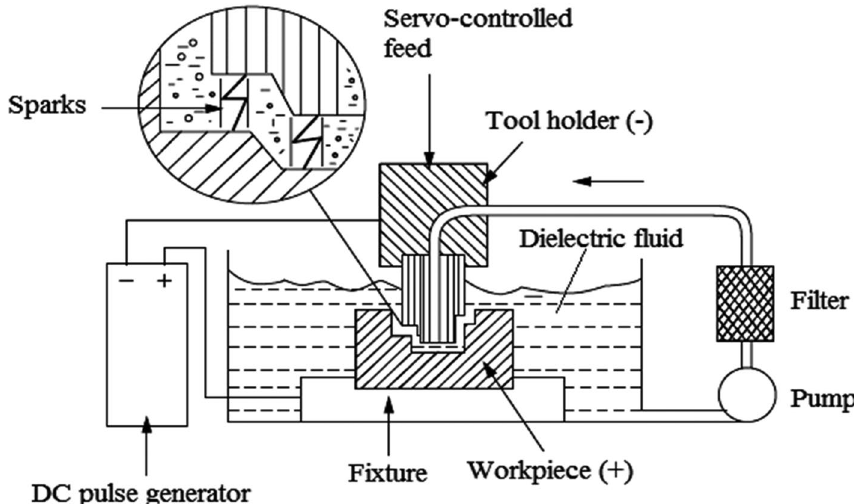
Fig. 4 Schematic of an EDM die-sink process